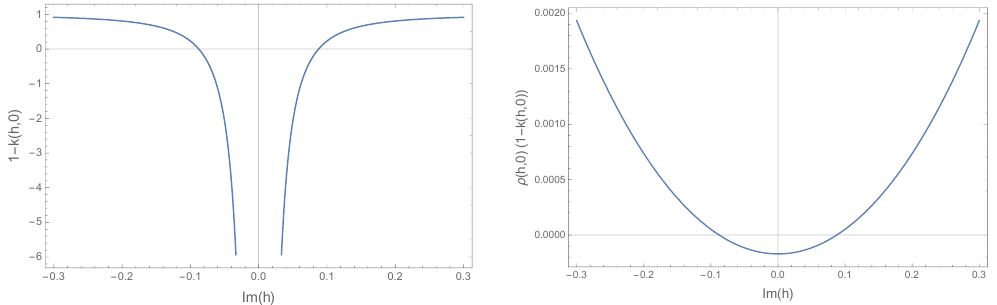
Figure 7 . Plot of 1 − k ( h, 0) (left) and ρ ( h, 0)(1 − k ( h, 0)) (right) at d = 3 and g = 1 < g c = 21 . 566 , along the principal series (2.11), for the long-range quartic O ( N ) 3 model, whose kernel eigenvalue is given in